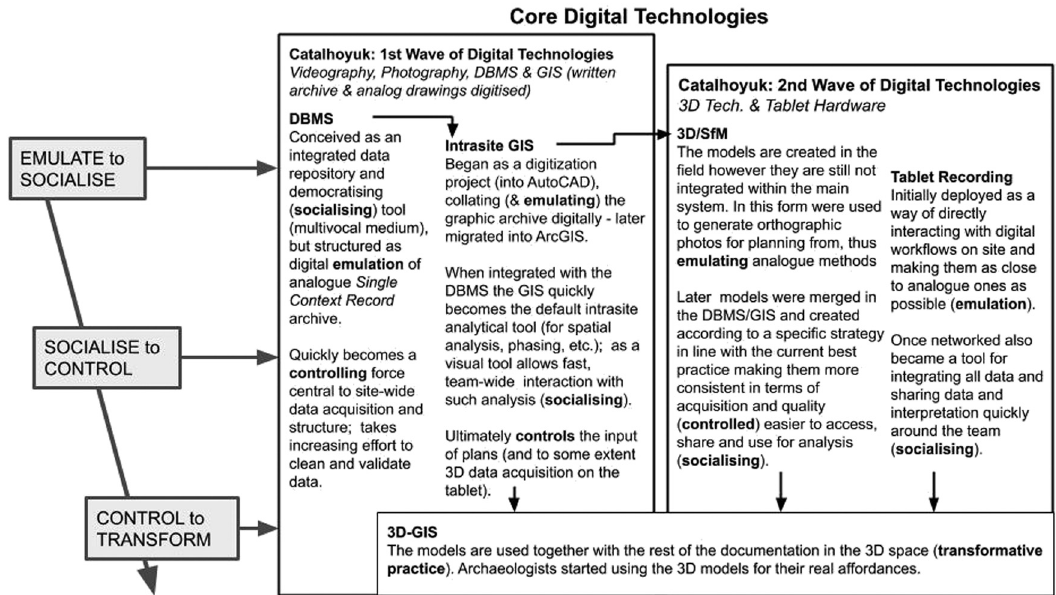
Figure 3: Diagram showing how the core digital technologies, which comprised the digital infrastructure at the Çatalhöyük Research Project, ultimately fi t into the schema outlined in Figure